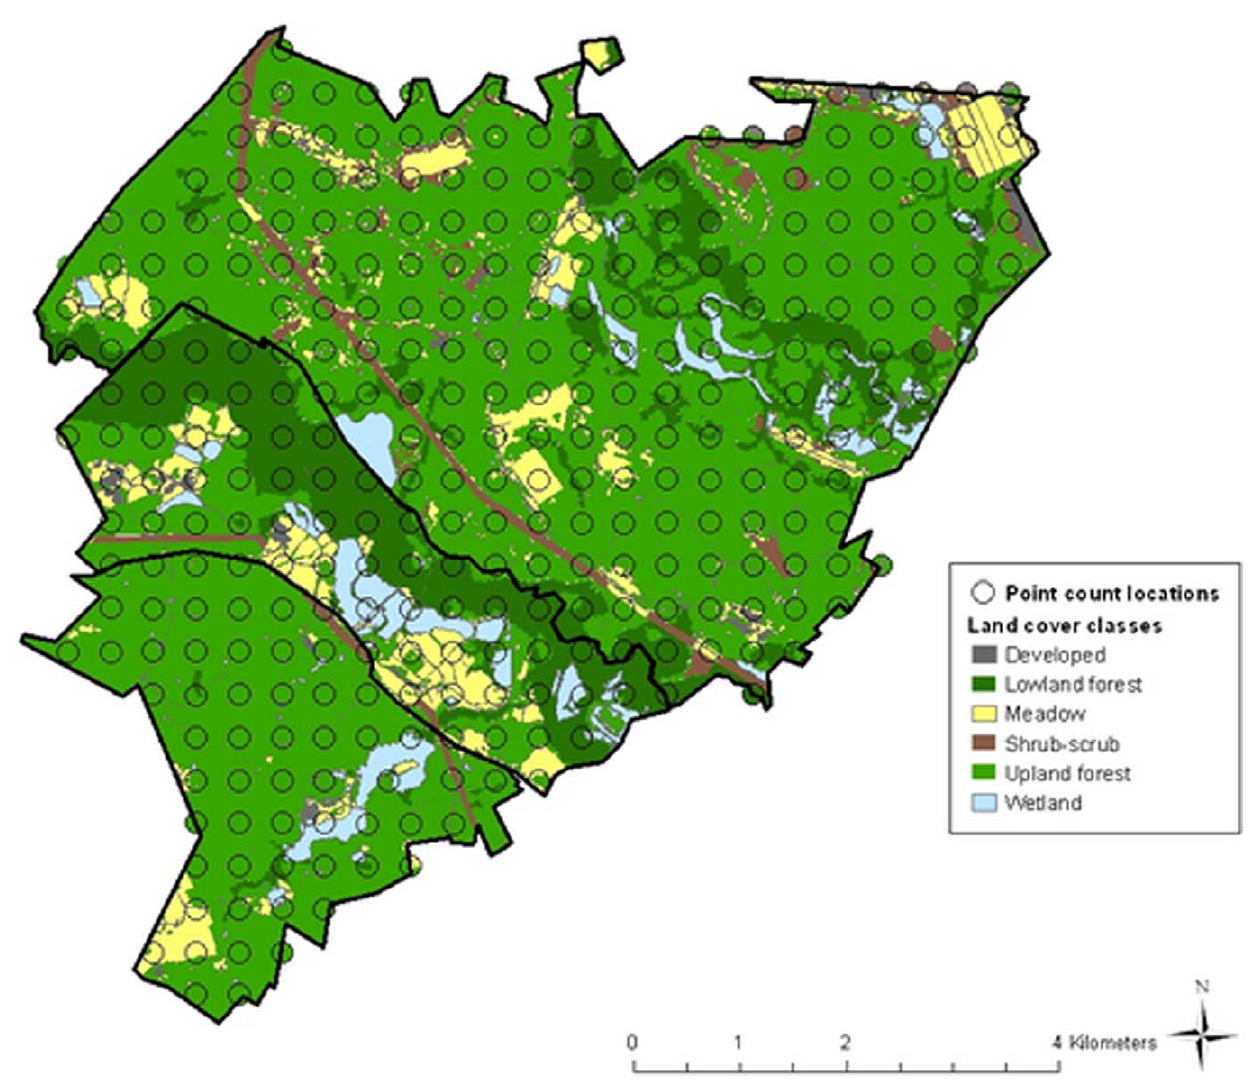
Figure 1. Map of 100-m radius buffers surrounding a grid of point-count stations throughout the Patuxent Research Refuge in Laurel, Maryland. Landcover is modified from the 1992 National Landcover Data set [24].